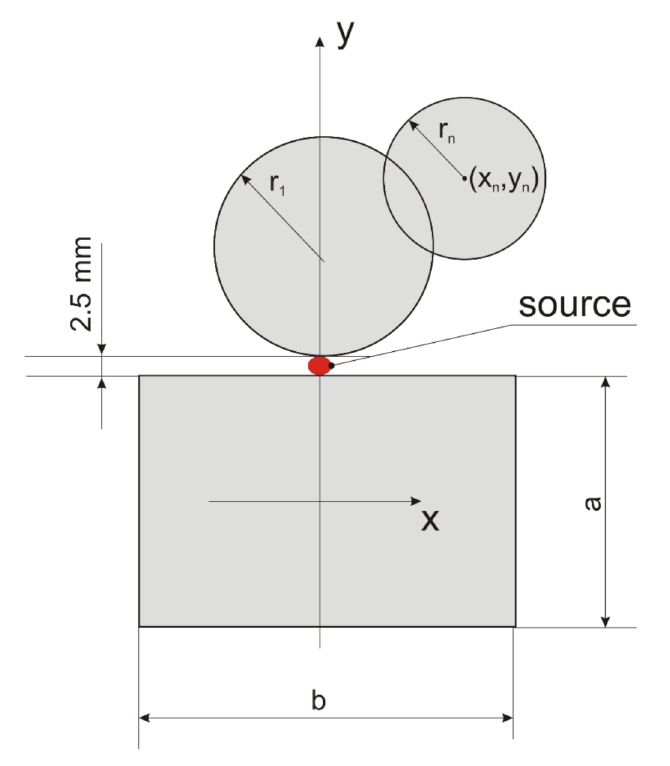
Figure 8. Design of wearable multiband antenna: design